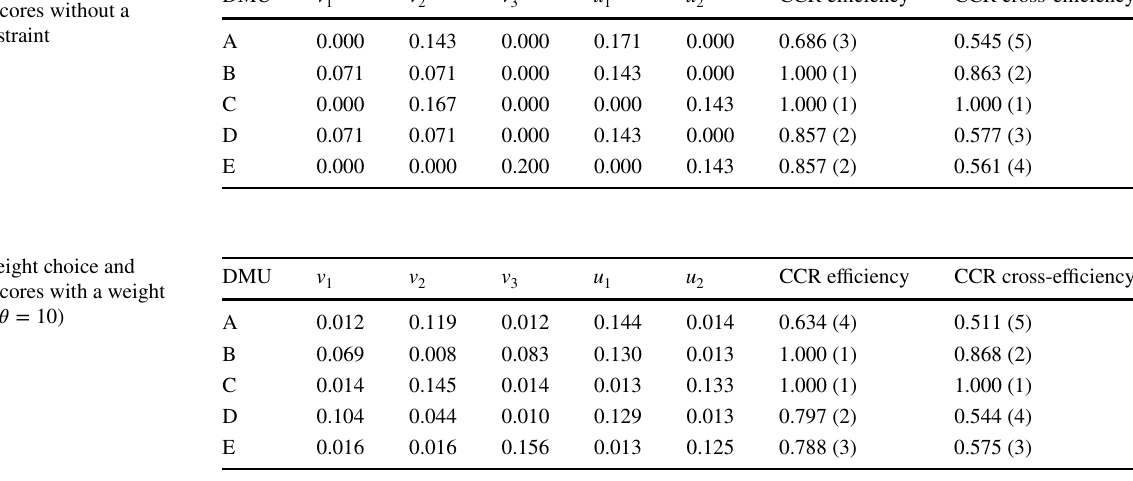
efficiency scores without a weight constraint